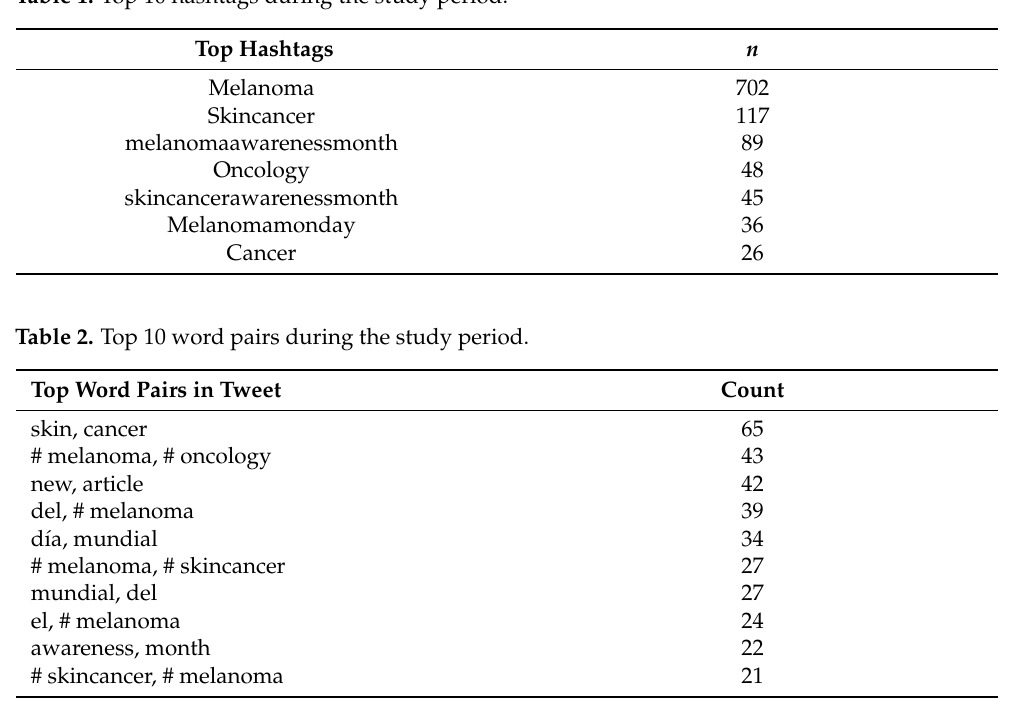
Table 1. Top 10 hashtags during the study period.